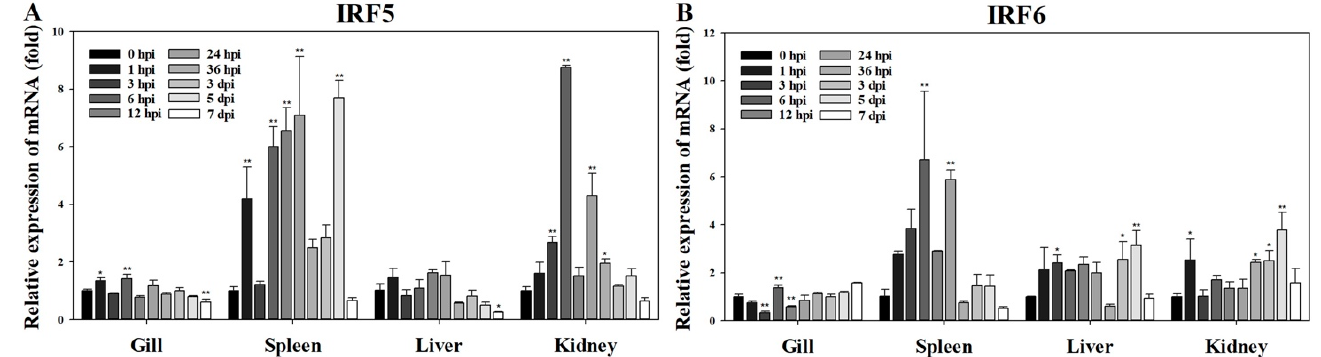
Figure 4. Expression pattern of ( A ) IRF5 and ( B ) IRF6 mRNA in the gill, spleen, liver, and kidney of red sea bream infected with RSIV. The PmIRF5 and PmIRF6 transcription levels were compared to that of the EF-1 α using RT-qPCR. The data are shown as the means ± SD of triplicate for each organ ( n = 3). Asterisks indicate differences (* p < 0.05, ** p < 0.01) compared with the control (0